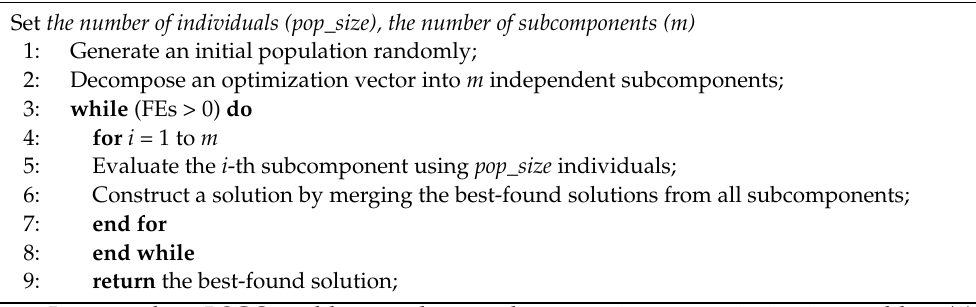
Algorithm 1 The classic CC-based